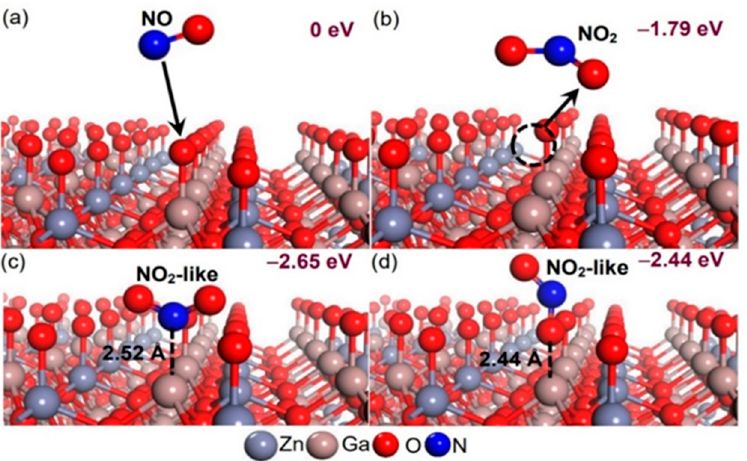
Figure 10. Sequence shows the ( a ) NO exposure on the oxide-passivation ZGO surface, ( b ) NO 2 away from the ZGO surface, ( c , d ) NO 2 -like molecules on the oxide-passivation ZGO surface. The atoms are represented by spheres: Zn (gray, large), Ga (brown, large), O (red, medium), and N (blue, medium). The gas adsorption-induced electrical resistance changes are intimately related to their respective electronic bonding properties. The total charge densities of the oxide-passivation ZGO surface, the oxide-passivation ZGO surface with one surface oxygen removed, and a nitrogen (oxygen) atom from a NO 2 -like molecule to Ga atoms on the ZGO (111) surface are shown in Figure 11. The contour levels are drawn at intervals of 0.038 electrons Å − 3 , with the lowest contour level at 0.038 electrons Å − 3 . Before adsorption of nitric oxide, the charge densities around the oxide-passivation ZGO surface are 0.038 electrons Å − 3 irrespective of the presence of surface oxygen being removed as observed in Figure 11a,b. After nitric oxide adsorption, we clearly see that nitric oxide and surface oxygen tend to combine significantly to form NO 2 with smooth isosurfaces and the charge density as high as 0.190 electrons Å − 3 is localized on the midpoint positions between NO 2 and surface gallium atoms as shown in Figure 11c. This suggests that the adsorption of nitric oxide on the surface of ZGO confines the electrons near the adsorption site, which reduces the conductivity and increases the resistance. In the case of a nitrogen atom from an NO molecule bonded to a surface oxygen atom to form a NO 2 -like molecule with smooth isosurfaces, electrons with a charge density of 0.152 electrons Å − 3 occupy the midpoint positions between NO 2 and surface gallium atoms as shown in Figure 11d.